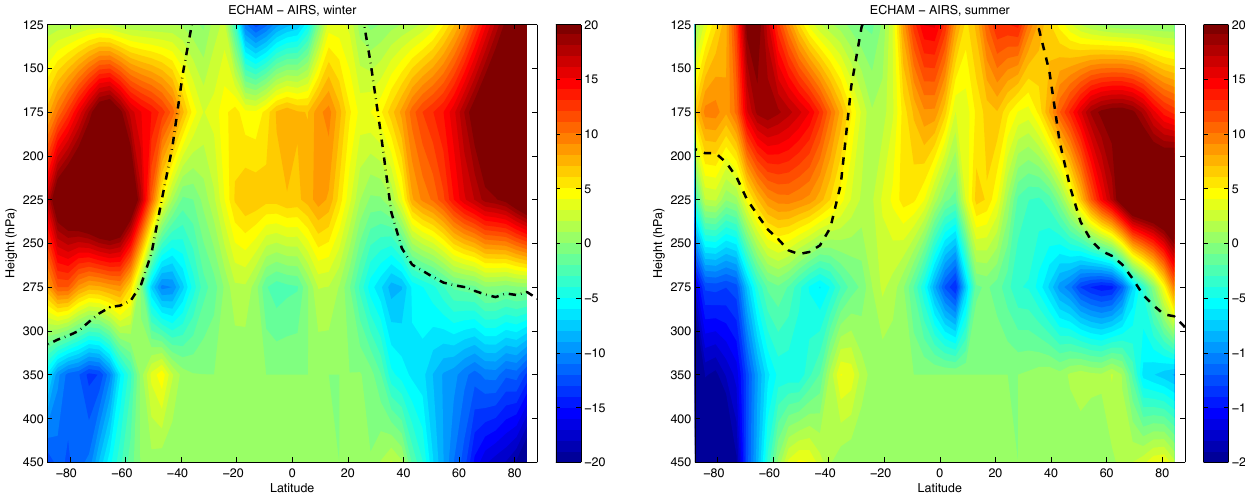
Fig. 22. Zonal means of ice supersaturation occurrence differences between ECHAM and AIRS (left) for the boreal winter (left) and summer (right). Dashed line: zonal mean summer tropopause. Pointed dashed line: zonal mean winter